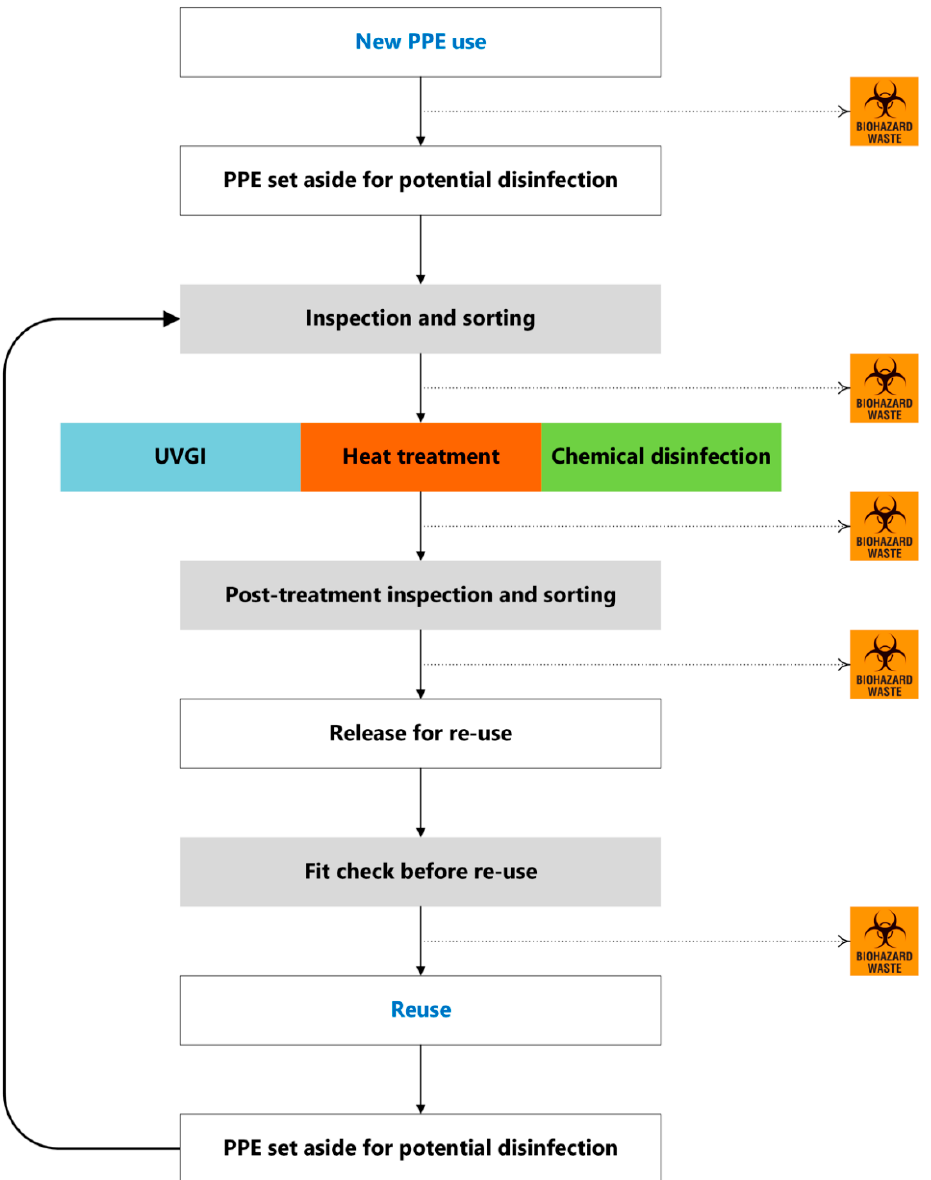
Figure 1. Proposed steps for a possible protocol for PPE disinfection and reuse. Dotted lines represent